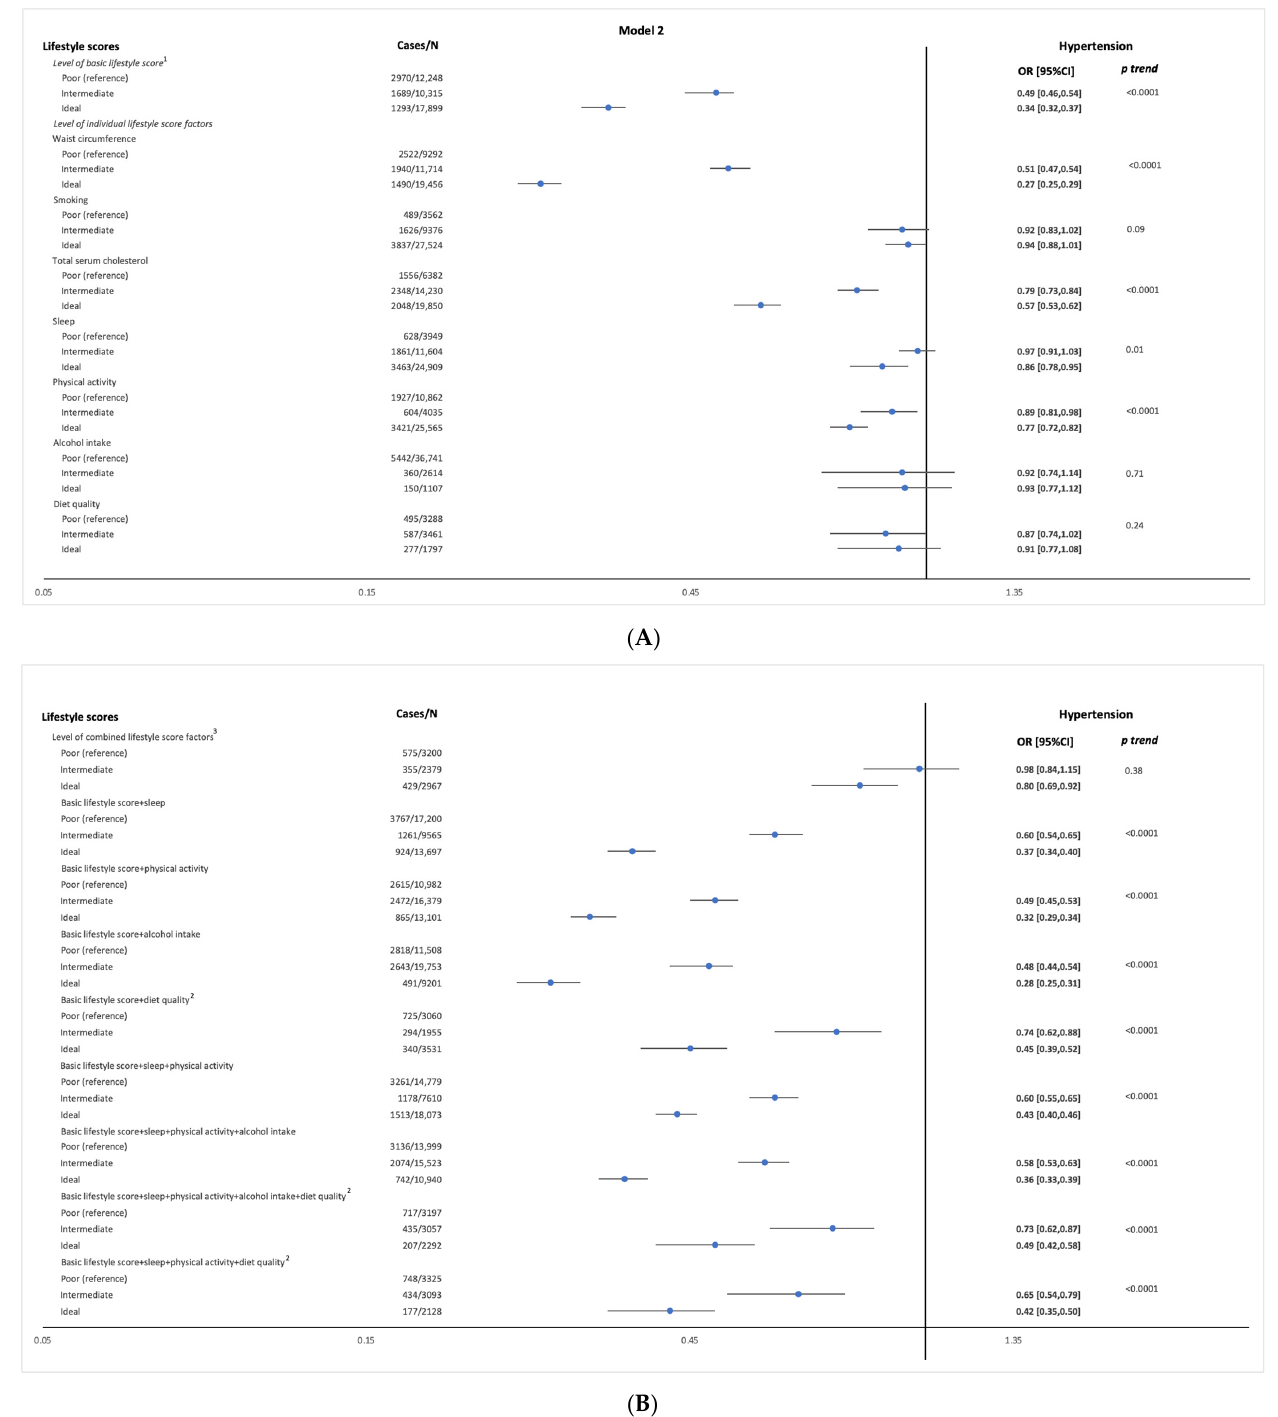
Figure 2. Odds ratio [95%CI confidence intervals] of hypertension per 1-point increase in levels of ( A ) basic, individual, and ( B ) combined lifestyle score factors in a sample of the Airwave Health Monitoring Study ( n = 40,462). Model 1 is adjusted for age, sex, and employment country. Model 2 is model 1 adjusted for marital status, education, ethnicity, annual household income, and history of chronic diseases. Hypertension was defined as having SBP ≥ 140 mmHg or DBP ≥ 90 mmHg, reported diagnosis or on anti-hypertensive medication 1 Basic lifestyle score includes (waist-circumference + smoking + cholesterol) 2 Analyzed in a subsample of n = 8546 3 . Combined lifestyle score factors include (sleep + physical activity + alcohol intake + diet quality). A 1-point higher waist-circumference-score was associated with − 3.63 mmHg lower SBP (95% CI: − 3.80, − 3.47) and a − 3.53 mmHg lower DBP (95% CI: − 3.64, − 3.42). Similarly,